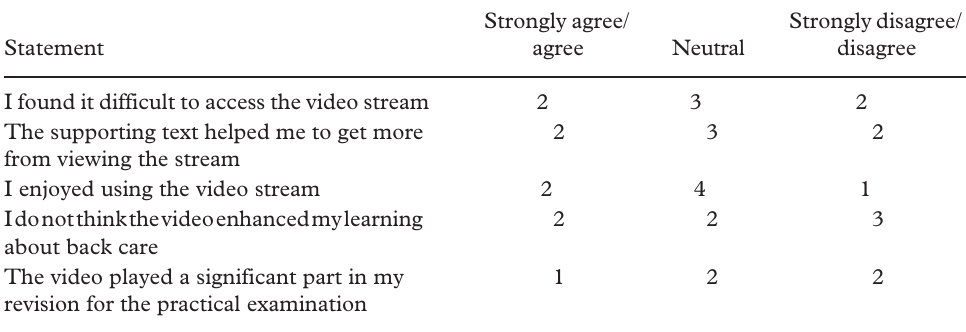
Table 1. Responses from students who had made use of the video in